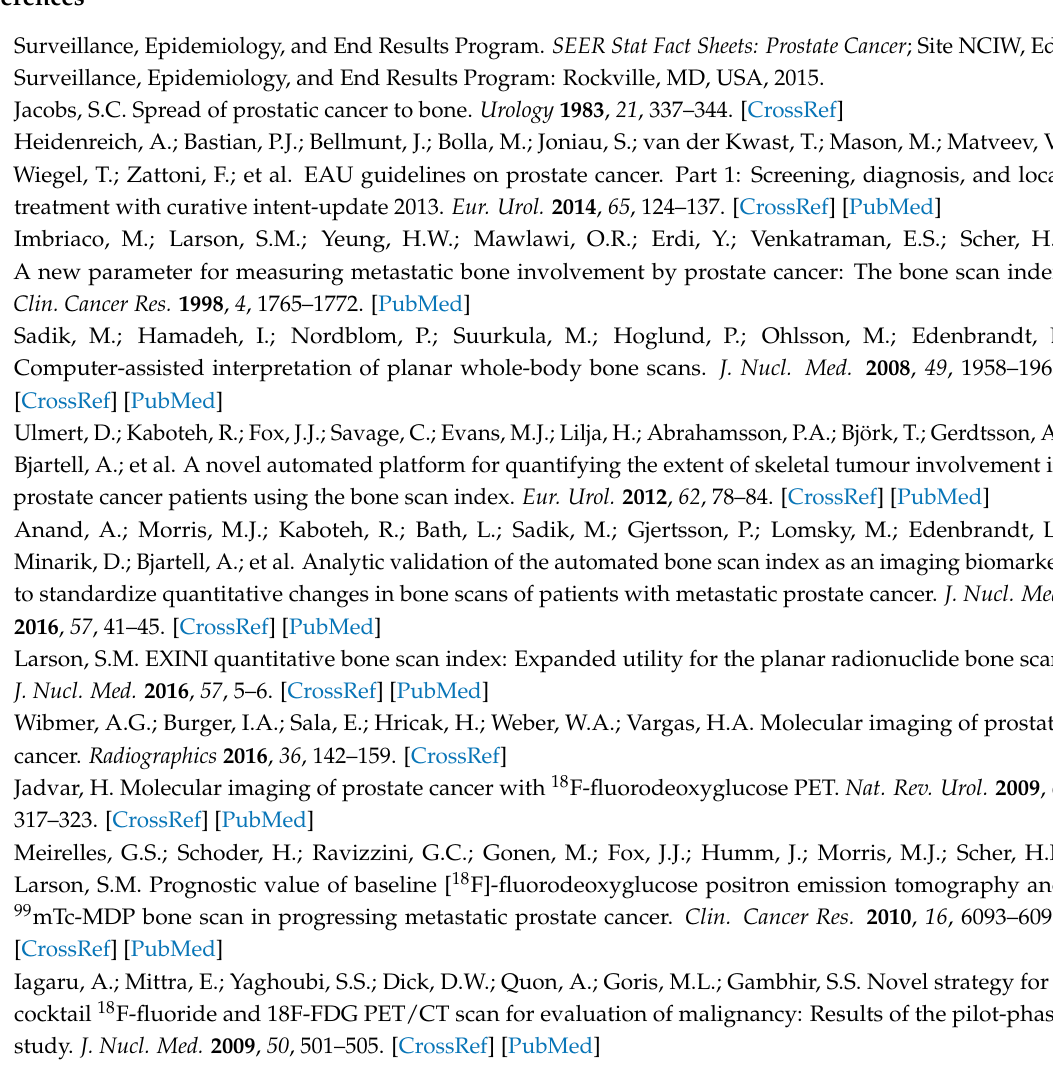
Table S1: Serum levels of the different biomarkers as well as the numbers of bone lesions (#bl) detected by visual analysis of the bone scans (bsv) and by the semiautomatic software package (bse), as well as in the PET/CT examination for individual